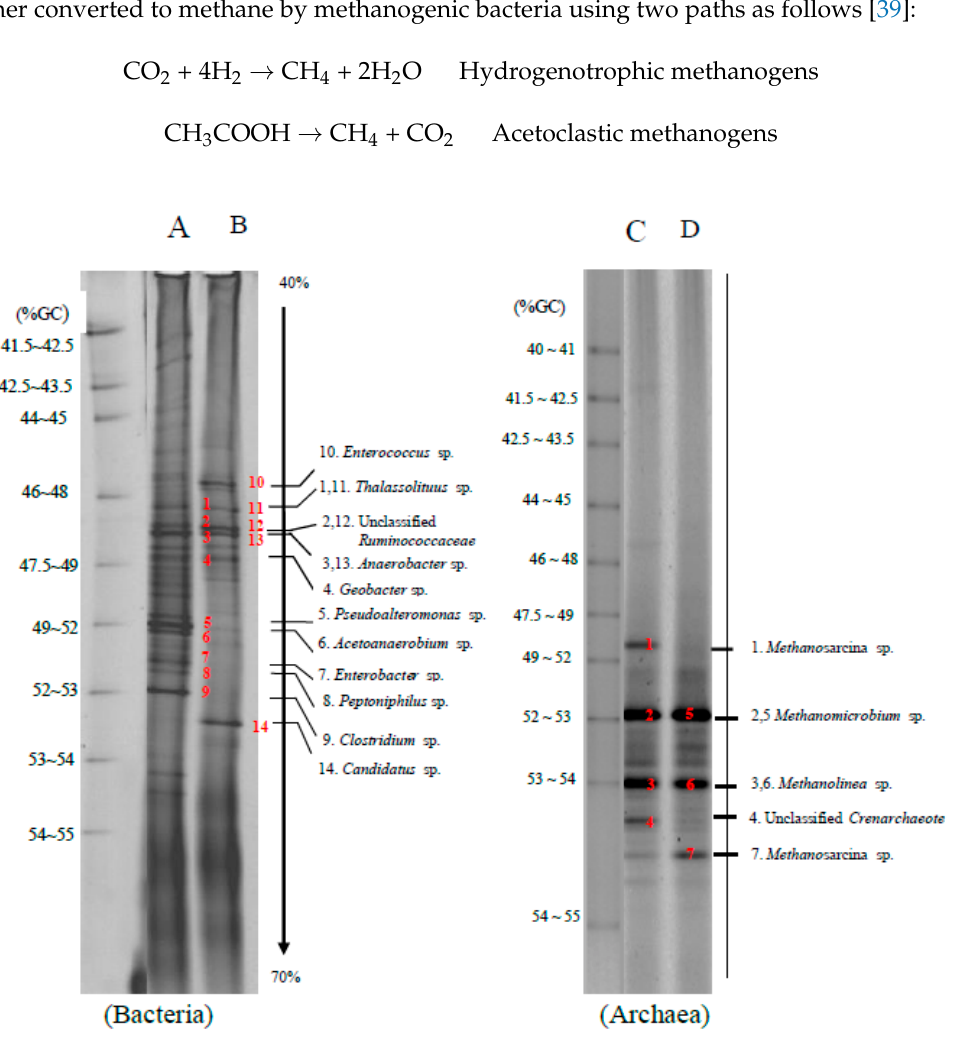
Figure 3. Polymerase chairn reaction and denautring gradeint gel electrophoresis (PCR-DGGE) profiles of bacteria and archaea at the end of the methane production from a co-digestion of grass with cow dung and silage with cow dung by anaerobic sludge at the optimal mixing ratio of 3:1. Lanes A and B: bacteria community from a co-digestion of grass with cow dung and silage with cow dung, respectively. Lanes C and D: archaea community from a co-digestion of grass with cow dung and silage with cow dung, respectively.